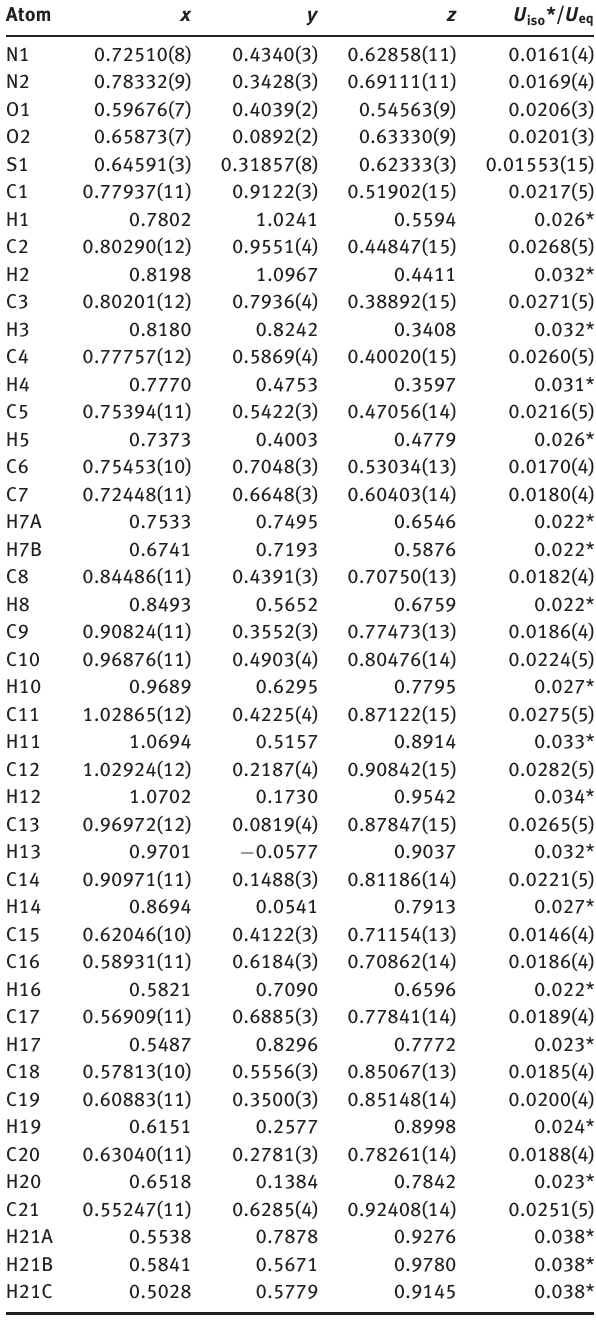
Table 2: Fractional atomic coordinates and isotropic or equivalent isotropic displacement parameters (Å 2